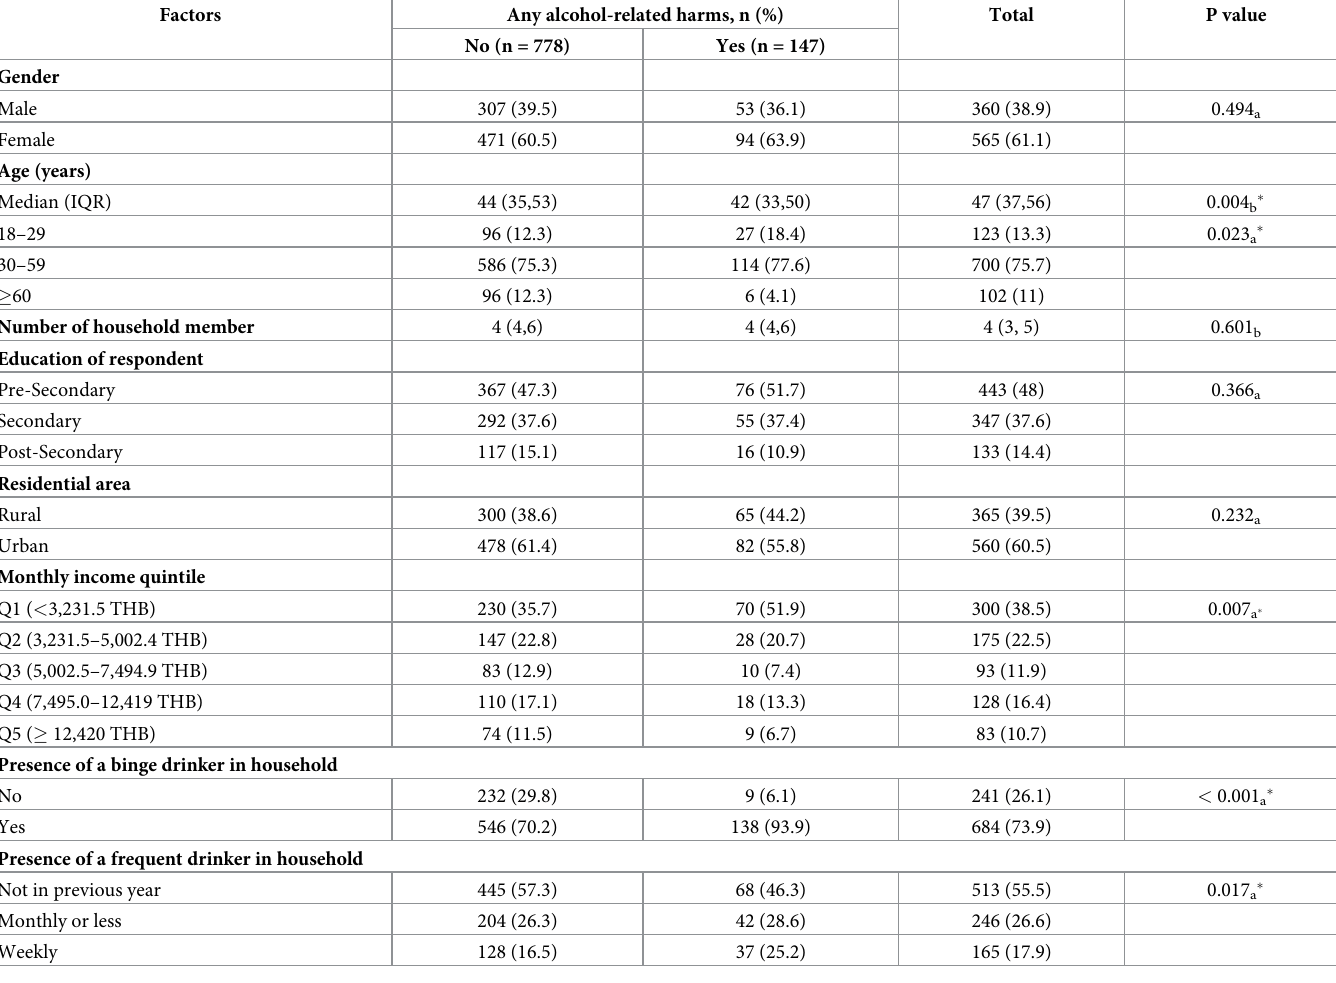
Table 3. Relationship between alcohol-related harms to children, demographic characteristics and presence of drinker in